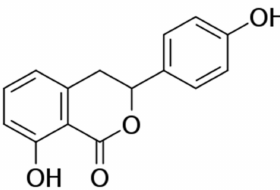
Figure 1. Chemical structure of